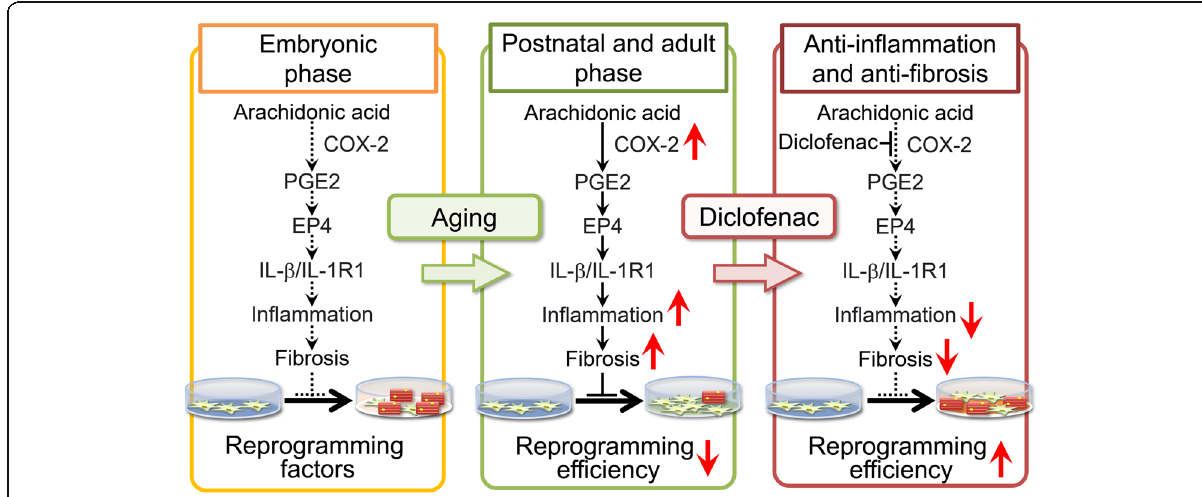
Fig. 3 Age-related inflammation and fibrosis are barriers to direct cardiac reprogramming [29]. With aging, fibroblasts activate the COX-2/PGE2/ EP4/IL-1 β /IL-1R1 pathway. These signaling pathways suppress myocardial induction via expression of fibrosis-related genes (left and middle panels). Diclofenac promotes myocardial induction by suppressing this pathway (right